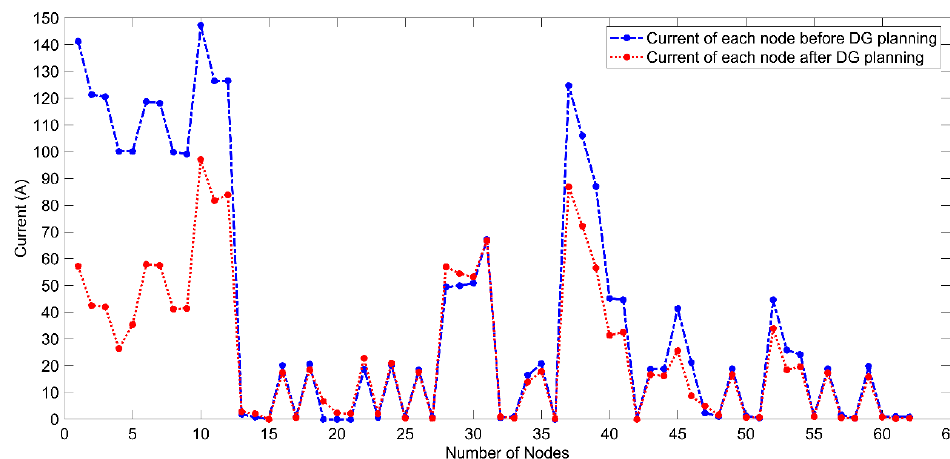
Figure 6. Current comparison of each node before and after DG access.